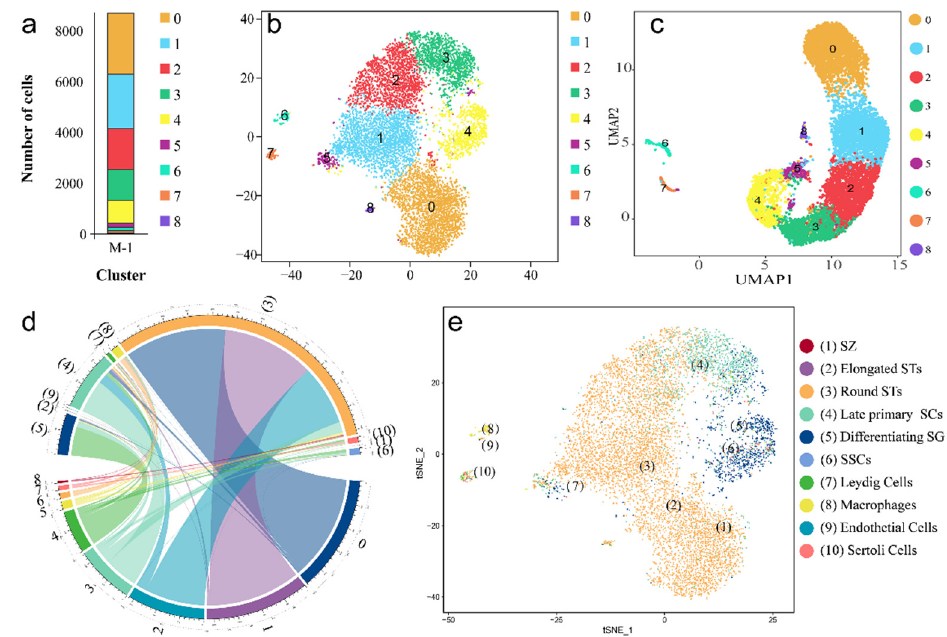
Figure 2. Cell clustering and annotation. ( a ) Distribution of cell number in each cluster. ( b ) Sequenced single cell clusters identified by t-SNE. Each dot represents a cell. ( c ) Sequenced single cell clusters identified by UMAP. ( d ) Distribution of each cluster compared with the ten cell types of human adult testis. The data was visualized via Circos software. 0–8, cluster 0–8 in orange-spotted grouper; (1)–(10), ten cell types in human testis. ( e ) The distribution of each cell types after comparing with the human testis visualized by t-SNE. SSC, spermatogonia stem cell; SG, spermatogonium; SC, spermatocyte; ST, spermatid; SZ, spermatozoon.